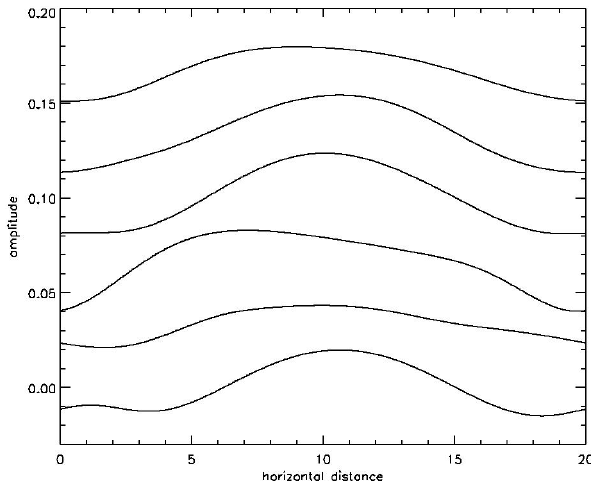
Fig. 7. Line plots of cuts taken through the contours of Fig. 6. Cuts are taken near z = − 0.36 though vary slightly from panel to panel to demonstrate maximum response.